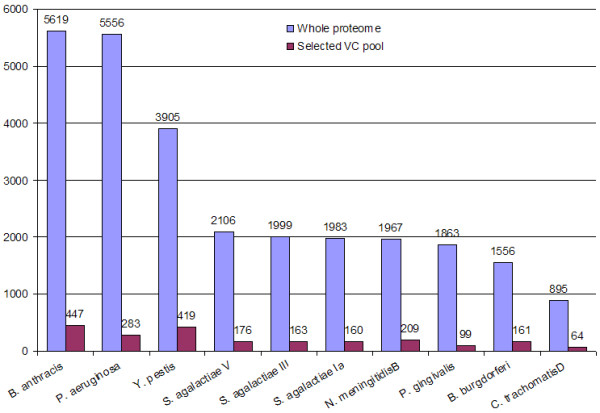
Data concerning the ten proteomes used for tuning NERVE. The number of selected VCs is reported beside the overall number of sequences. The average size of the selected VC pools is 8.17% of the proteome (min 5.09%, max 10.73%).